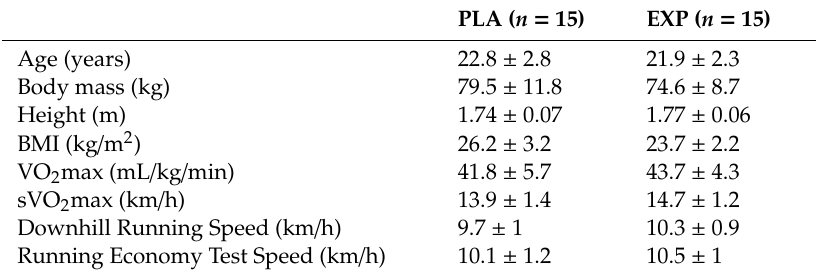
Figure 2. The absolute changes in oxygen uptake ( A ) and perceived effort ( B ) over time following downhill running. * p < 0.05 compared to the baseline values in the same group. ‡ p < 0.05 compared to the experimental group at the same time-point. CON: control group; EXP: experimental group. The isometric peak torque significantly decreased ( p < 0.05) for both groups immediately after DHR and remained so throughout the entire experimental period for the control group, but fully recovered 72 h post-DHR for the experimental group (Figure 3).